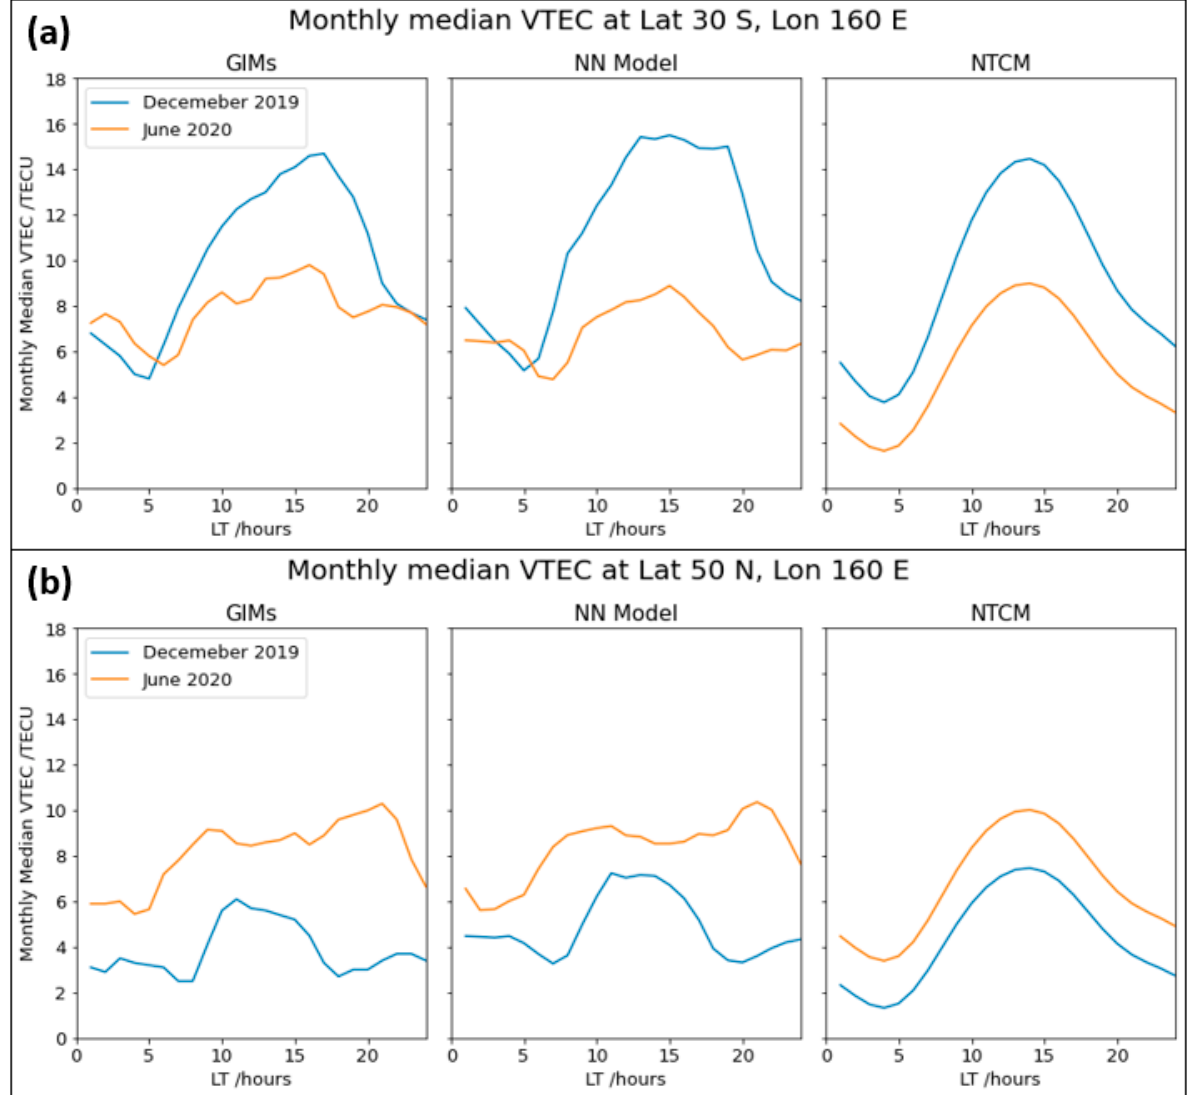
Figure 7. Monthly median VTEC plotted against LT for the Southern Hemisphere’s NWA for the Asian sector ( a ) and at the conjugated location ( b ).